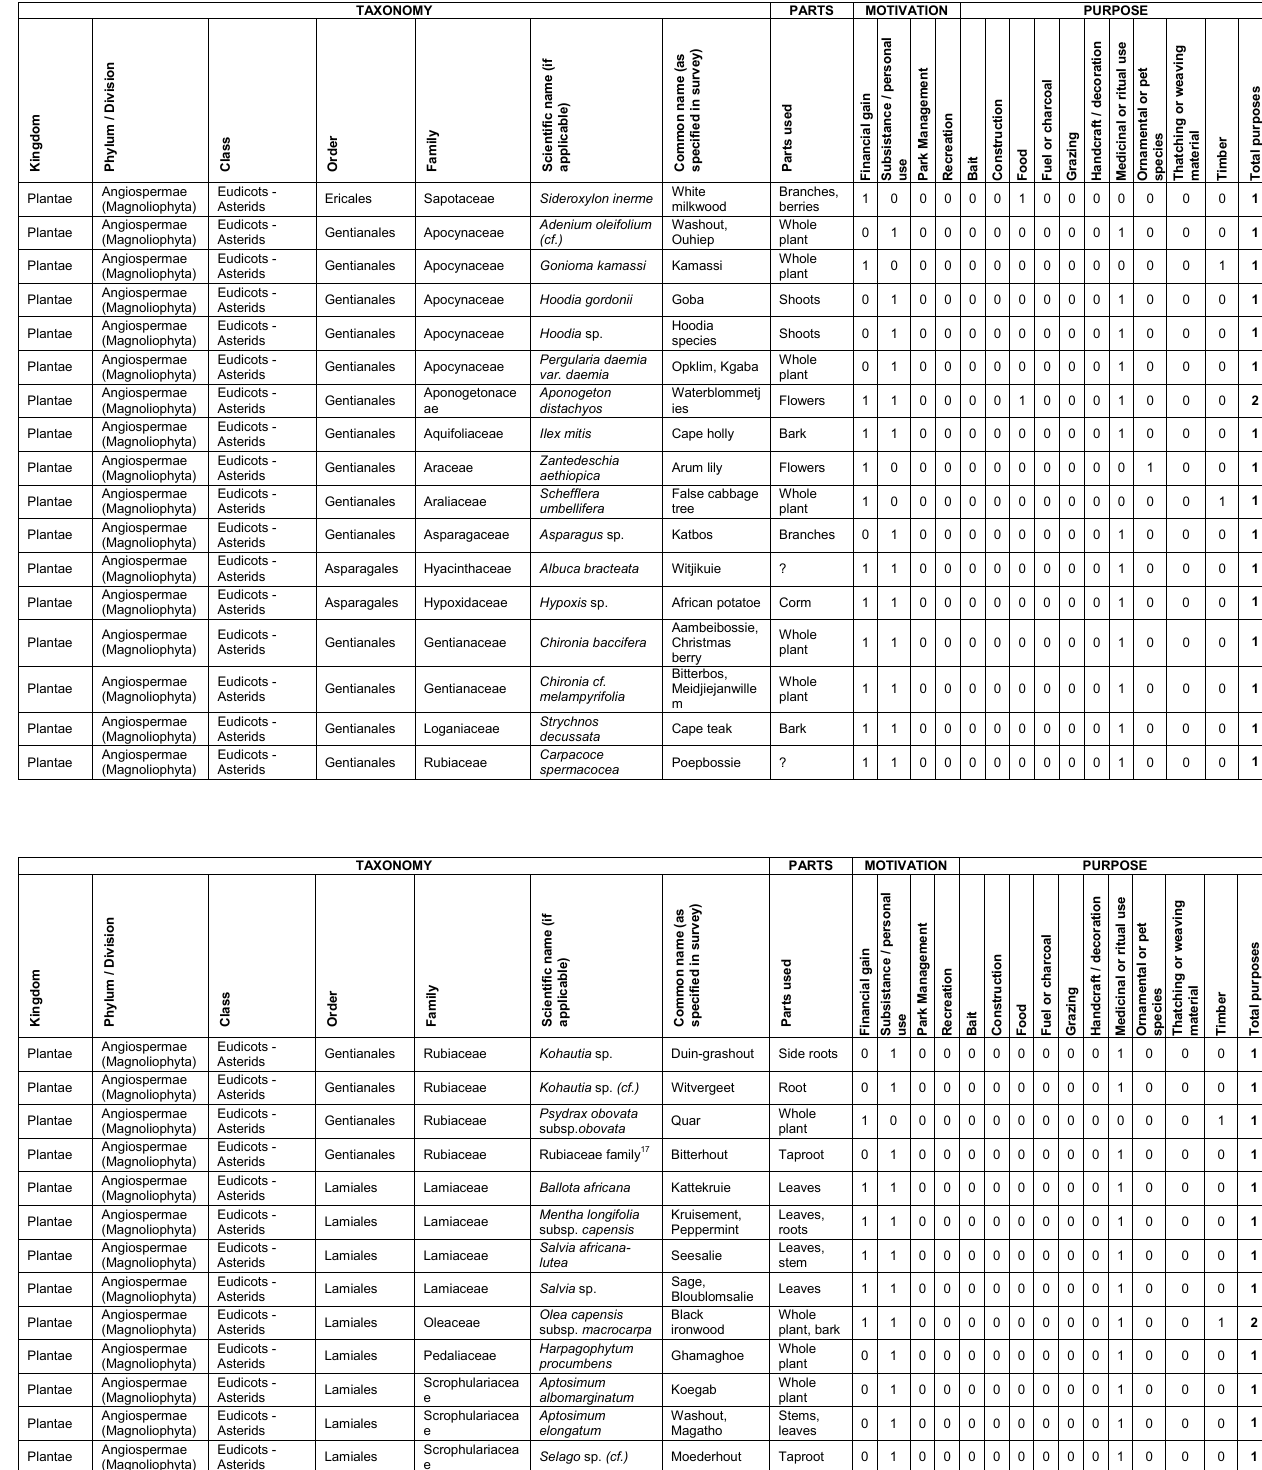
Plantae Angiospermae (Magnoliophyta) Eudicots - Asterids Lamiales Scrophulariacea e Aptosimum albomarginatum Koegab Whole plant Plantae Angiospermae (Magnoliophyta) Eudicots - Asterids Lamiales Scrophulariacea e Aptosimum elongatum Washout, Magatho Stems, leaves 0 1 0 0 0 0 0 0 0 0 1 0 1 Plantae Angiospermae (Magnoliophyta) Eudicots - Asterids Lamiales Scrophulariacea e Selago sp. (cf.) Moederhout Taproot Plantae Angiospermae (Magnoliophyta) Eudicots - Asterids Lamiales Stilbaceae Nuxia floribunda Forest elder Plantae Angiospermae (Magnoliophyta) Eudicots - Asterids Solanales Solanaceae Solanum sp. Jakalsbossie Plantae Angiospermae (Magnoliophyta) Eudicots - Rosids Celastrales Celastraceae Cassine peragua False saffron